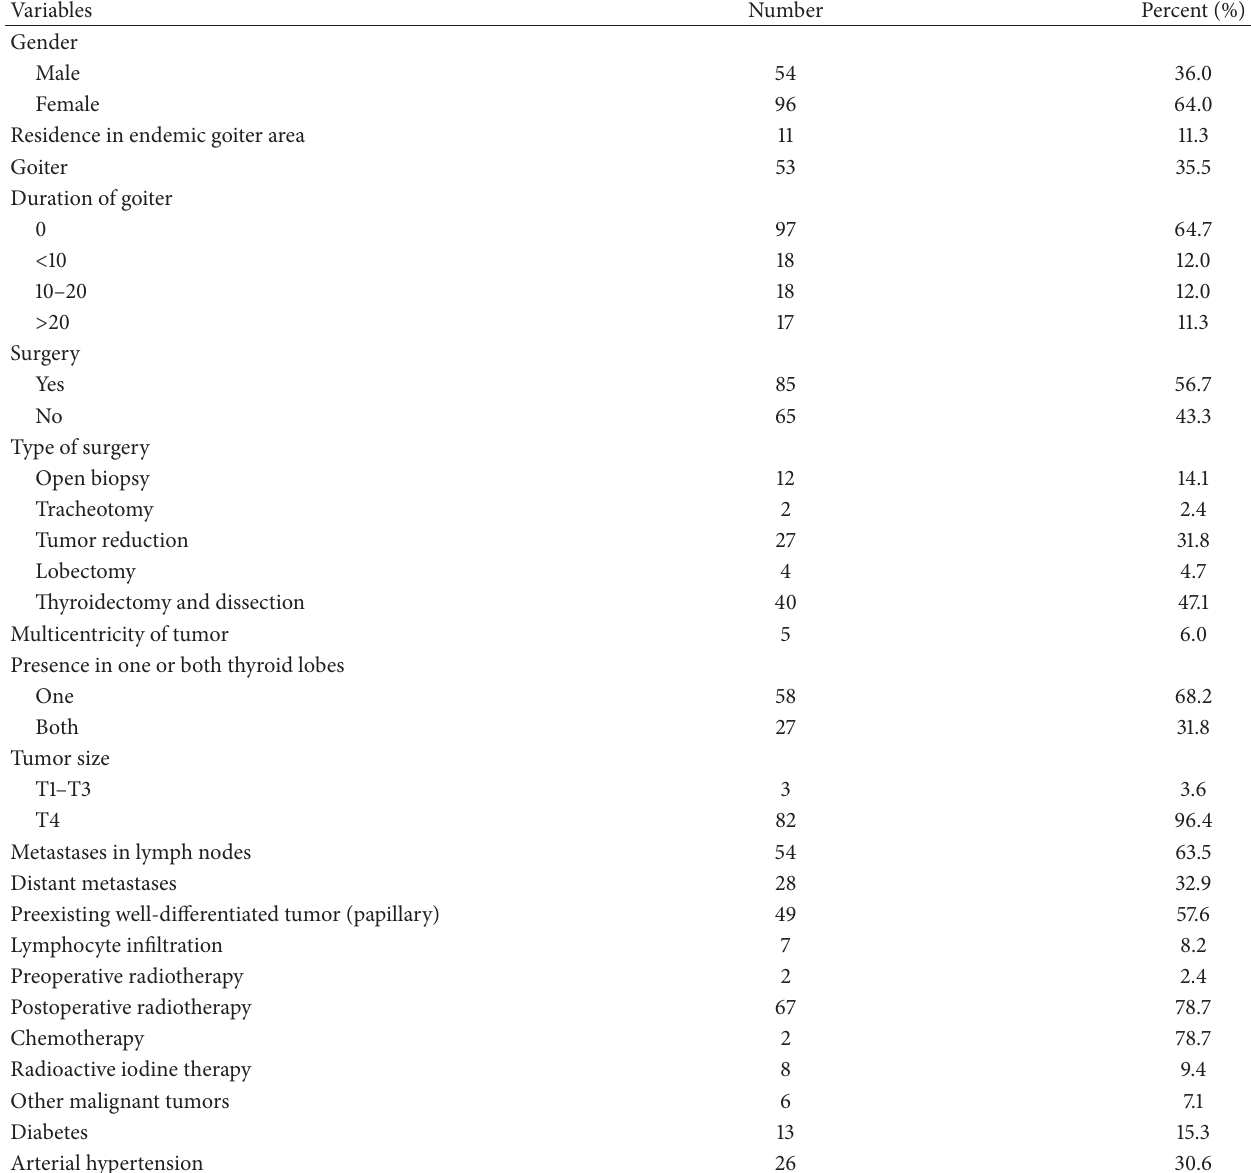
Table 1: Demographic and clinical characteristics of patients with anaplastic thyroid